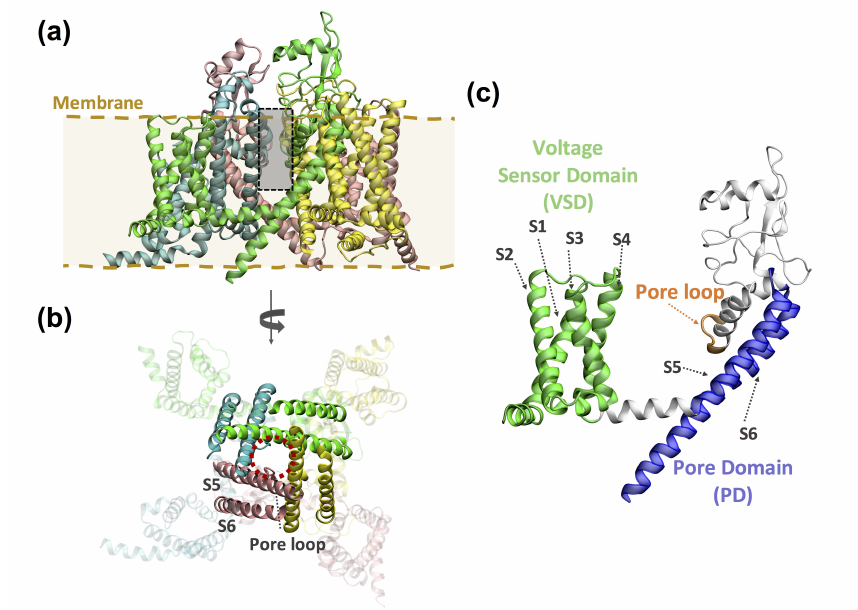
Figure 4. Representative structure of a tetrameric voltage-gated ion channel (VGIC). ( a ) Structure of the voltage-gated sodium channel Nav1.7, PDB code 6J8J [48], with protein subunits colored in green, yellow, pink and cyan, respectively. Only the pore-forming subunits are shown. The binding site of (photoswitchable) pore blockers is indicated with a gray box. ( b ) Alternative view of the same structure from the intracellular side. The helices displayed in solid colors correspond to the pore domain (S5 and S6 helices and the pore loop); the ion-conducting pore is indicated with a dashed red circle. ( c ) Detailed view of one Nav1.7 subunit indicating the two functional domains present in VGICs. The voltage sensor domain (VSD) has four transmembrane helices (S1–S4, colored in green) and the pore domain (PD) is constituted by two transmembrane helices (S5 and S6, in blue), connected by the pore (P-)loop, which contains the ion selectivity filter (in